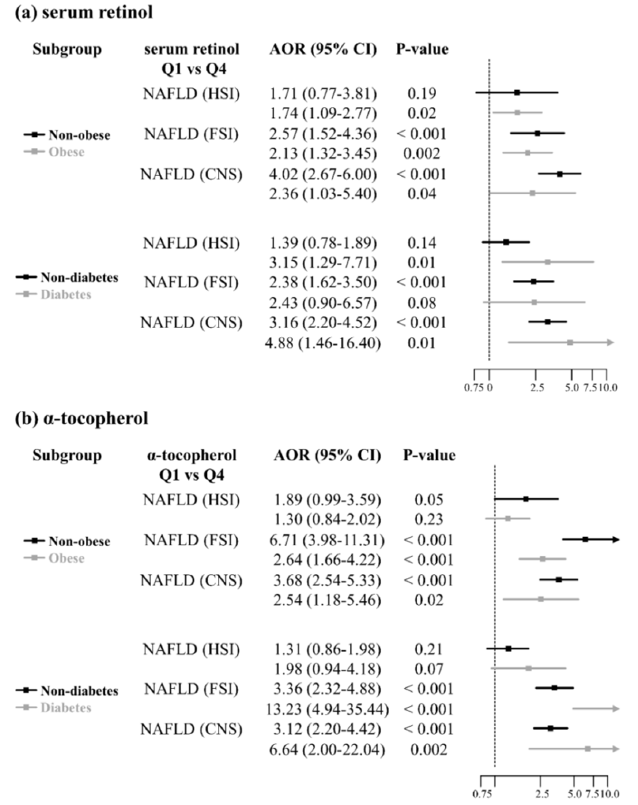
Figure 3. Subgroup analysis according to obesity and diabetes. The association between NAFLD status and vitamin (serum retinol and α -tocopherol) levels was estimated using logistic regression models. The logistic model was adjusted for age, sex, BMI, GFR, hypertension, diabetes, dyslipidemia status, income level, smoking status, alcohol consumption, exercise status, use of vitamin supplements, and daily dietary intake of vitamin A. The association remained significant for NAFLD according to FSI and CNS, except in diabetic patients according to FSI. Q, quartile; AOR, adjusted odds ratio; CI, confidence interval; NAFLD, non-alcoholic fatty liver disease; HSI, hepatic steatosis index; FSI, Framingham steatosis index; CNS, comprehensive NAFLD score.